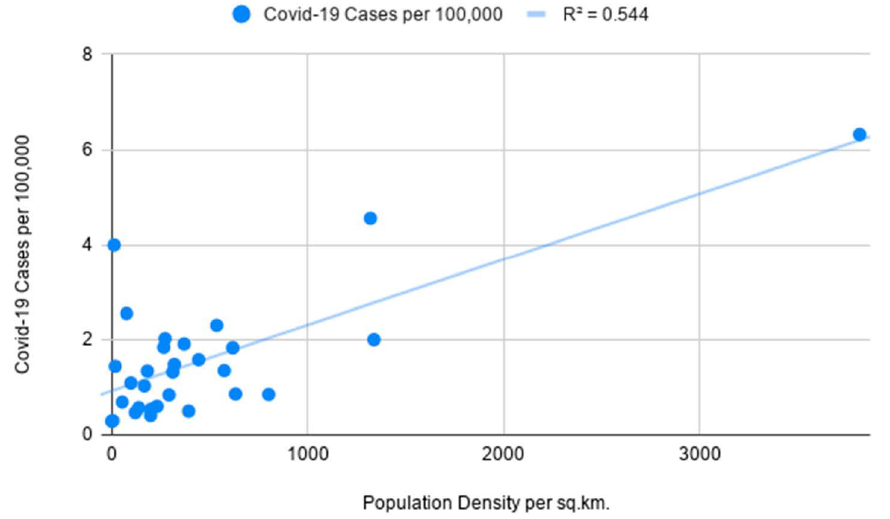
Figure 3. Simple linear regression with population density as an independent variable and Covid-19 cases as a dependent variable for China’s administrative divisions.